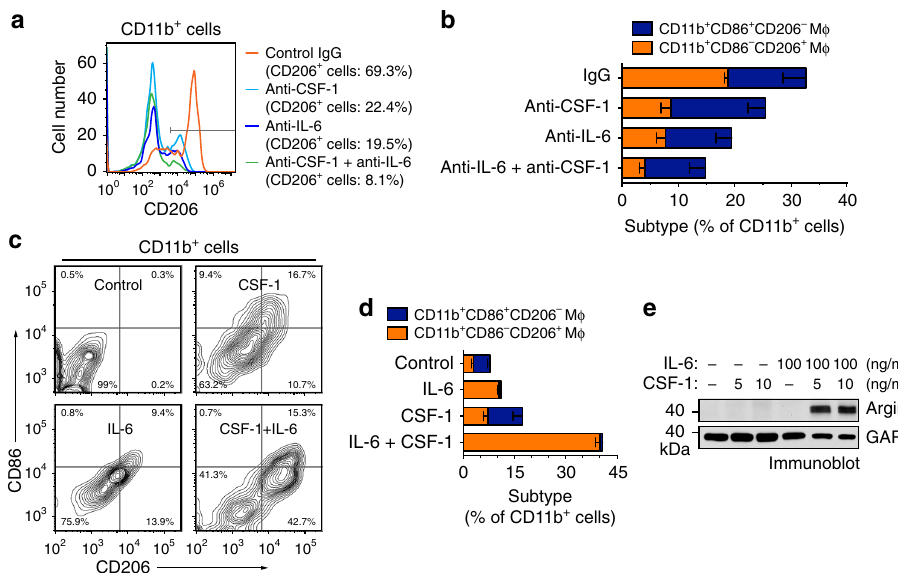
Fig. 4 IL-6 is critical for EC-induced macrophage alternative activation. a , b Mouse microvascular brain ECs were pretreated with the glioma-CM for 24 h. Mouse BM-derived macrophages were co-cultured with pretreated ECs for 5 days in the presence of control IgG, anti-CSF-1 antibody, or anti-IL-6 antibody or both antibodies. The cells were stained with anti-CD11b, anti-CD86, anti-CD206 antibodies, and analyzed by fl ow cytometry. a Representative sorting for CD206 expression in CD11b + cells. b Quanti fi ed data in sorted CD11b + cells ( n = 3 – 5, mean ± SEM). c – e Mouse BM-derived macrophages were treated with IL-6 and CSF-1 for 5 days. c , d The cells were stained with anti-CD11b, anti-CD86, and anti-CD206 antibodies, and analyzed by fl ow cytometry. c Representative sorting for CD206 and CD86 expression in CD11b + cells. d quanti fi ed data in sorted CD11b + cells ( n = 3, mean ± SEM). e Cell lysates